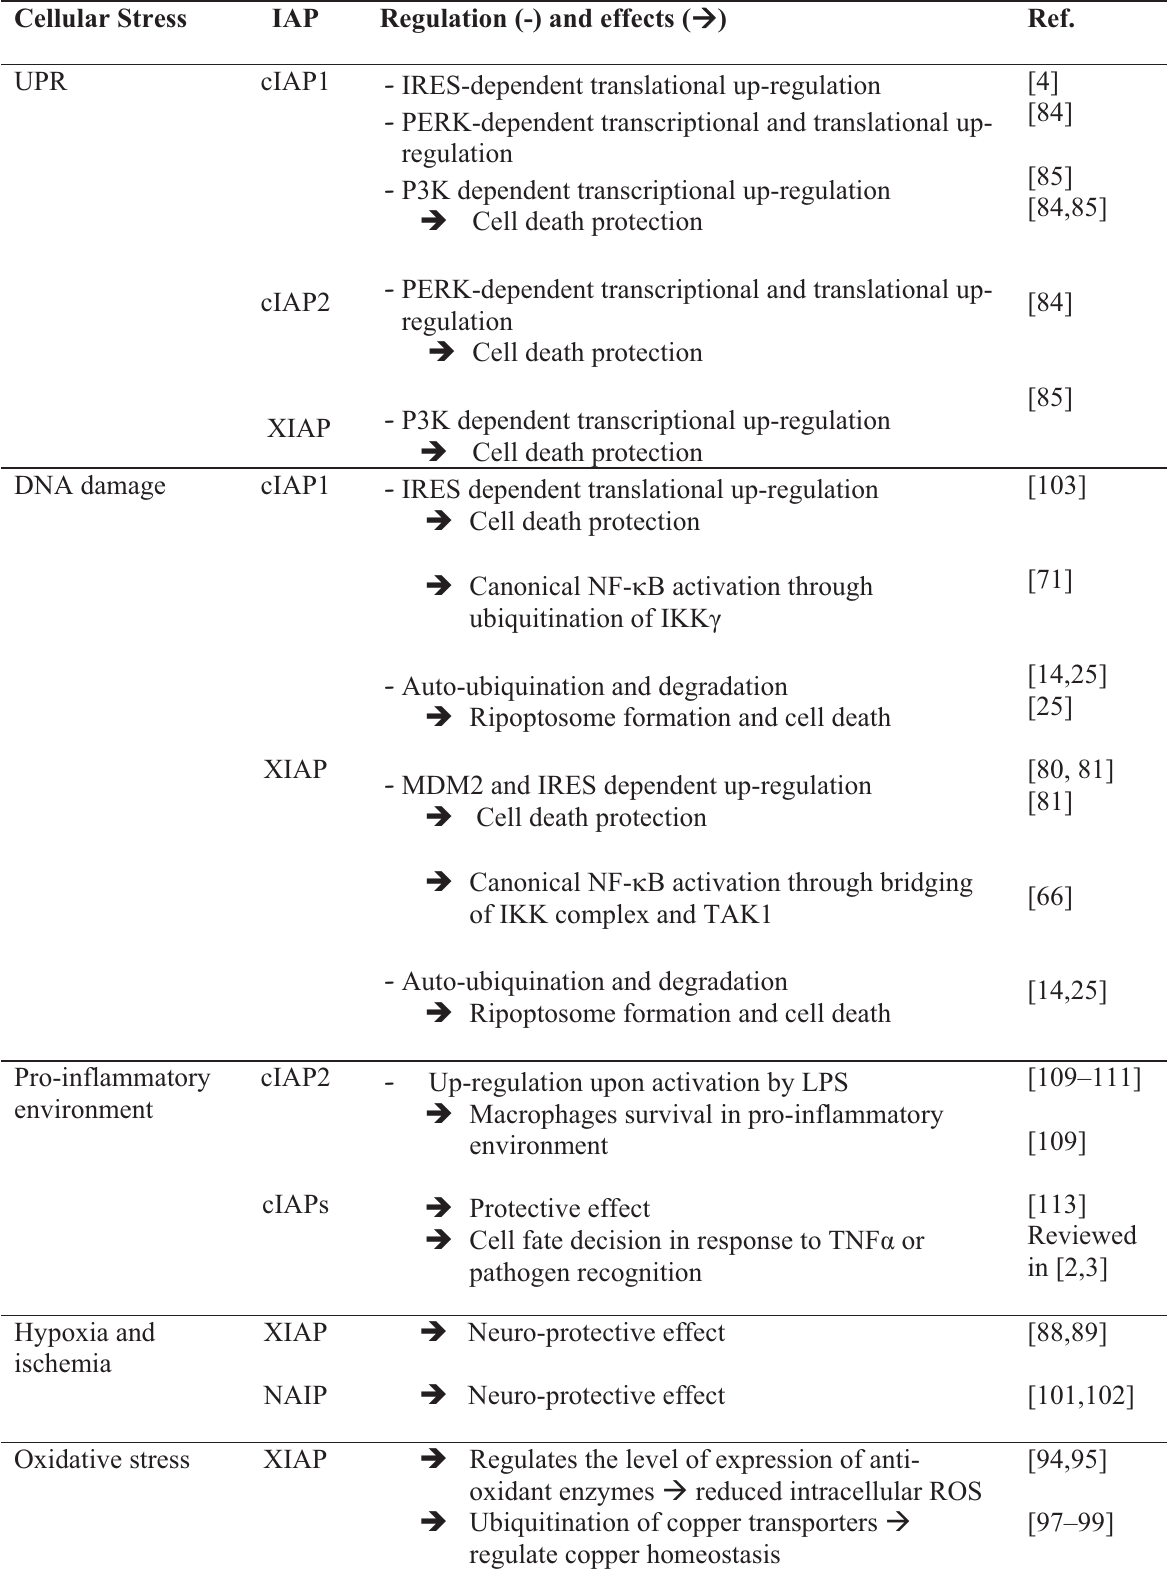
Table 1. Influence of IAPs in adaptive response to cellular stress. Cellular Stress IAP Regulation (-) and effects ( (cid:2) )